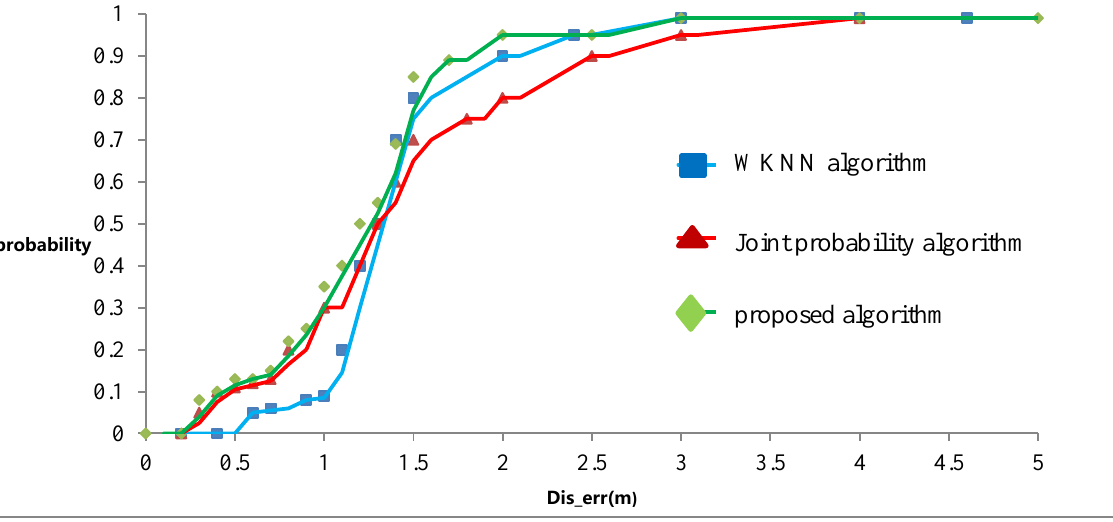
Figure 9. Probability distribution of 100